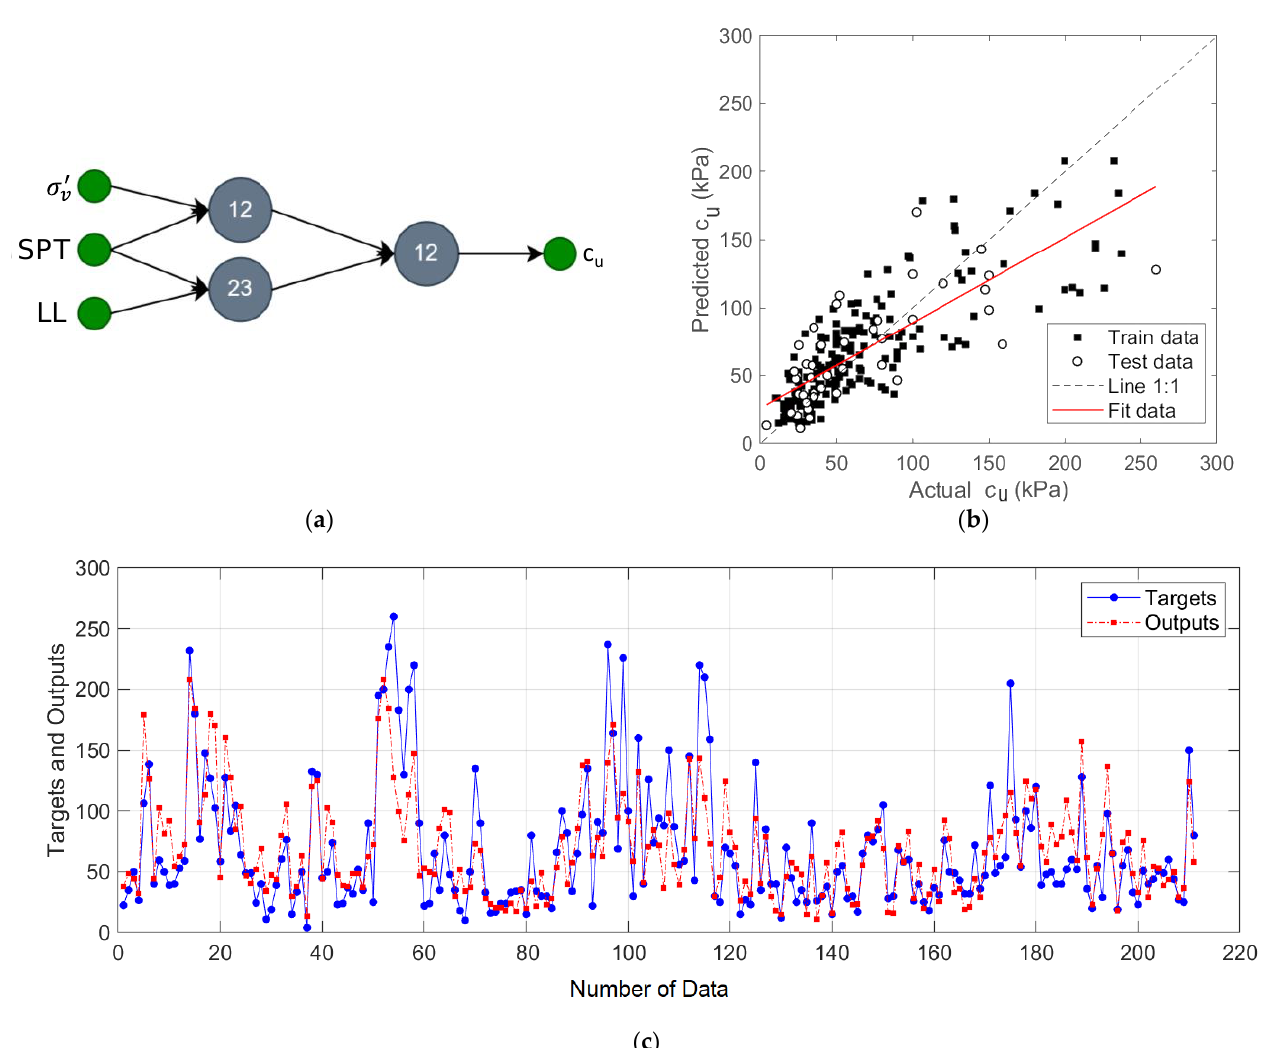
Figure 5. The proposed prediction model for input variables σ v ’ , N SPT , and LL : ( a ) two-layers GMDH-type NN structure; ( b ) regression plot; ( c ) target and output predictive values.